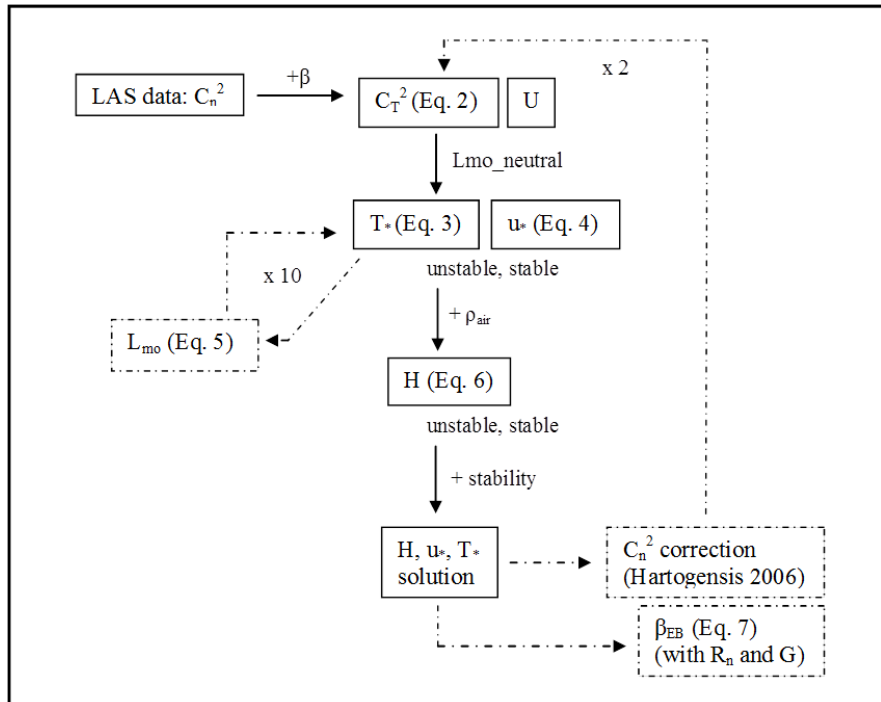
Figure 3. Simplified LAS data processing flowchart. Iterative processes are shown with a dashed line. ―β‖ represents Bowen Ratio, ―U‖ represents wind speed, ―L represents the initial guess of L represents the Bowen Ratio computed by energy